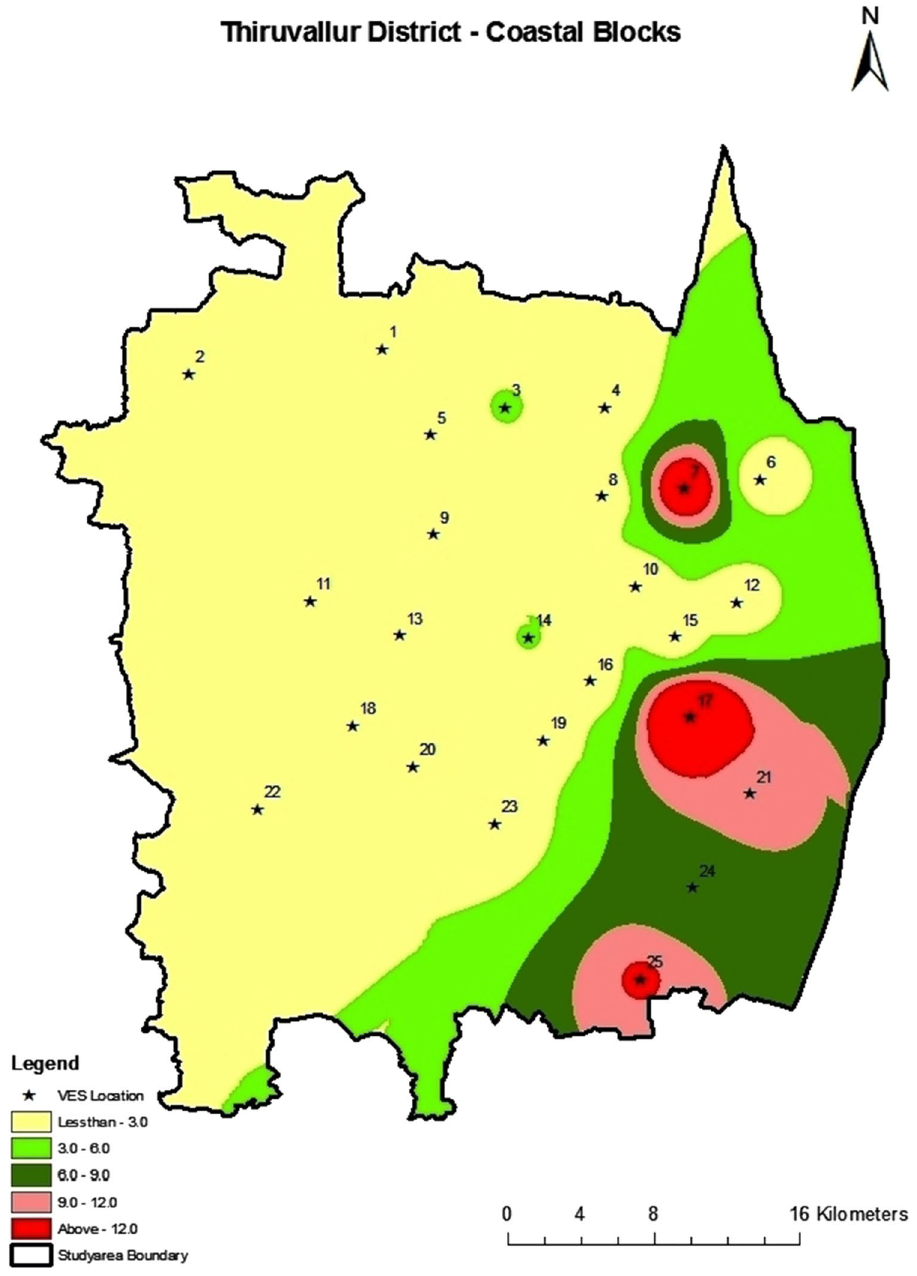
Fig. 14 Longitudinal conduct- ance ( S )